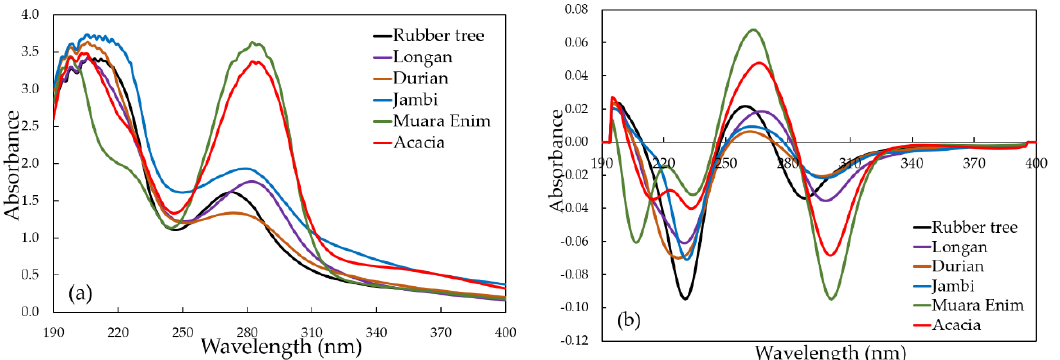
Figure 2. The average original ( a ) and pre-processed ( b ) spectra of the Indonesian honey with different botanical, entomo- logical, and geographical origins over the range of 190–400 nm.